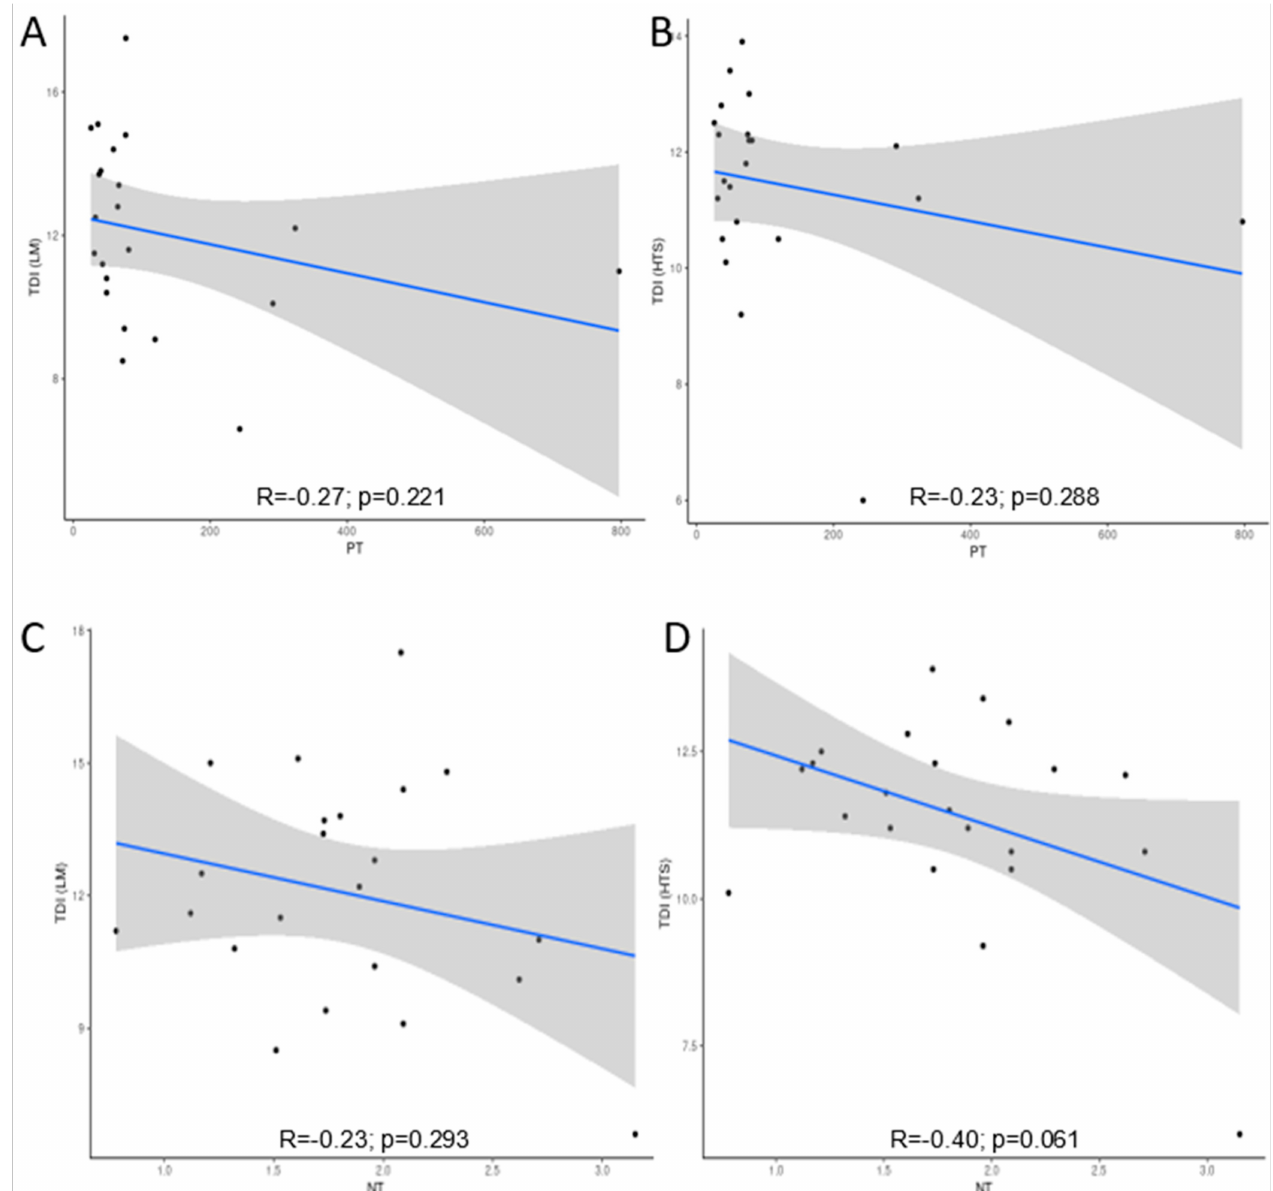
Figure 6. Correlation between Trophic Diatom Index (TDI) calculated from morphological (LM) and molecular (HTS) methods and ( A , B ) TP ( µ g L − 1 ) and ( C , D ) TN (mg L − 1 ). The grey bands are 95% confidence